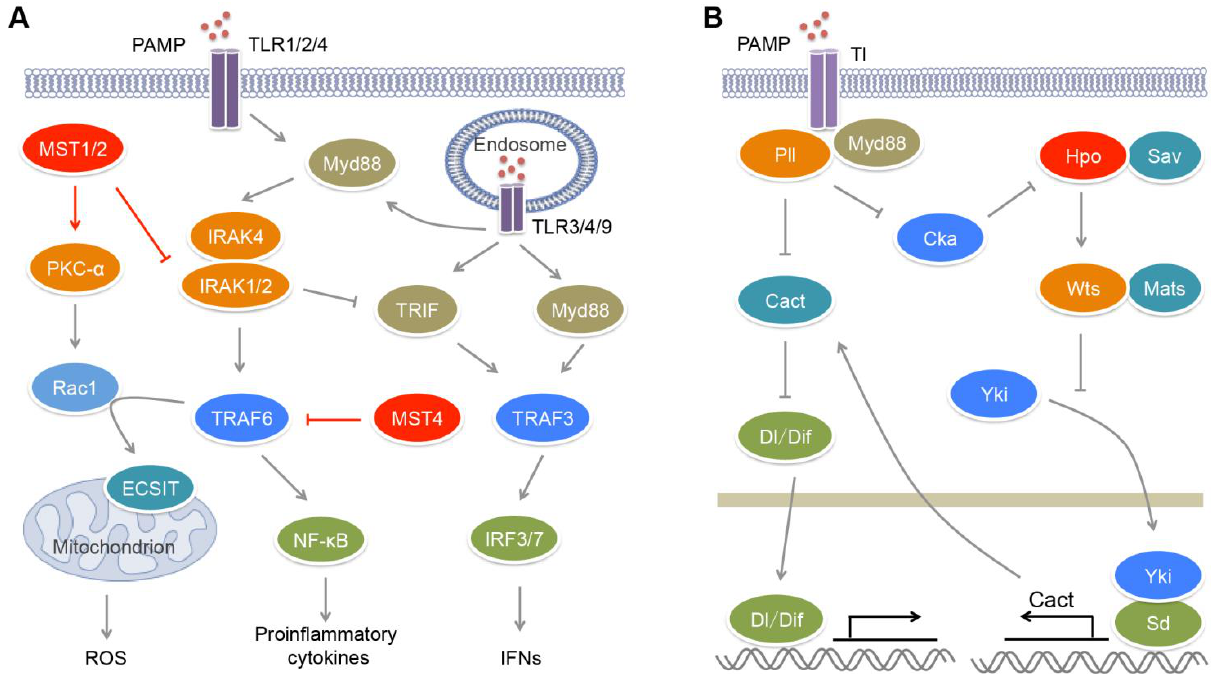
FIGURE 1: MST kinases in the regulation of TLR signaling. (A) In mammals, upon microbial infection, TLRs sense different kinds of PAMPs and promote the production of pro-inflammatory cytokines and IFNs through activating E3 ligases TRAF3/6 and transcription factors NF-κB and IRF3/7. TRAF6 also promotes mROS production in a Rac1- and ECSIT-dependent manner. MST1/2 could stimulate mROS production through PKC-α−Rac1−TRAF6−ECSIT pathway to clear pathogens. On the contrary, MST1 suppresses the upstream kinase IRAK1 of TRAF6 to limit the production of pro-inflammatory cytokines. MST4 also attenuates TLR-mediated inflammatory responses through directly phos- phorylating and inhibiting TRAF6. The inhibitory roles of MST1 and MST4 in proinflammatory response protect body against inflammatory damage and chronic inflammation-driven HCC. (B) In Drosophila , upon microbial infection, Tl receptor promotes the activation of Hpo ki- nase, which in turn restricts the transcription of Dl/Dif inhibitor Cact through Hippo signaling, and thus promotes Tl-mediated antimicrobial